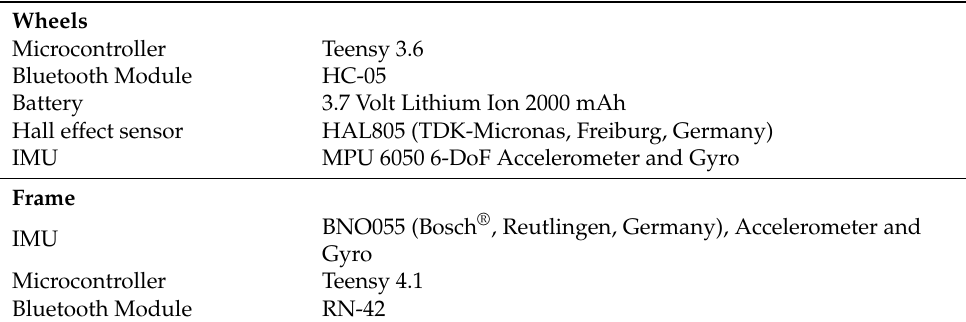
Table 2. Electronic Components of the BCIT